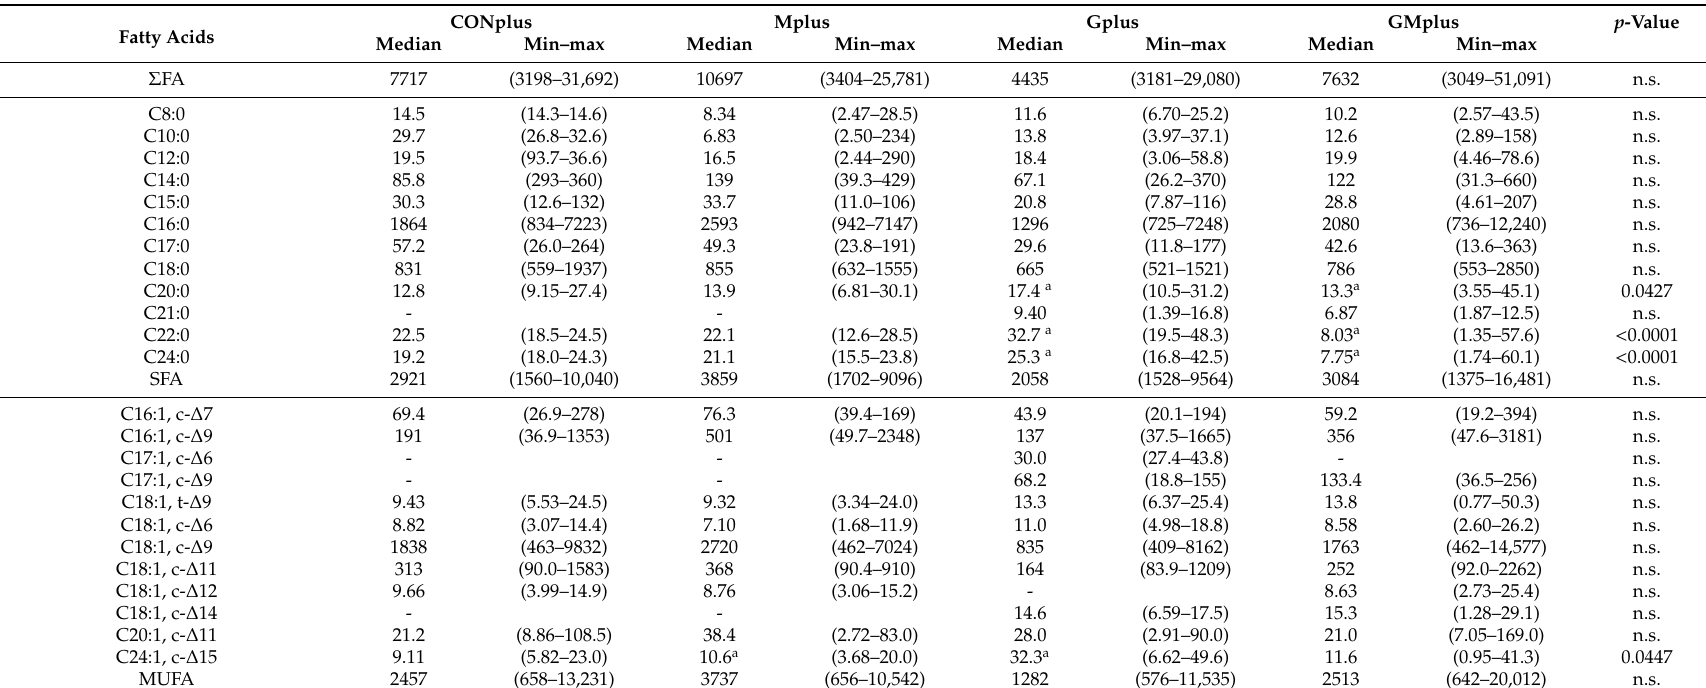
Table 3. FA content ( µ g / g of tissue) in mammary tumours of experimental